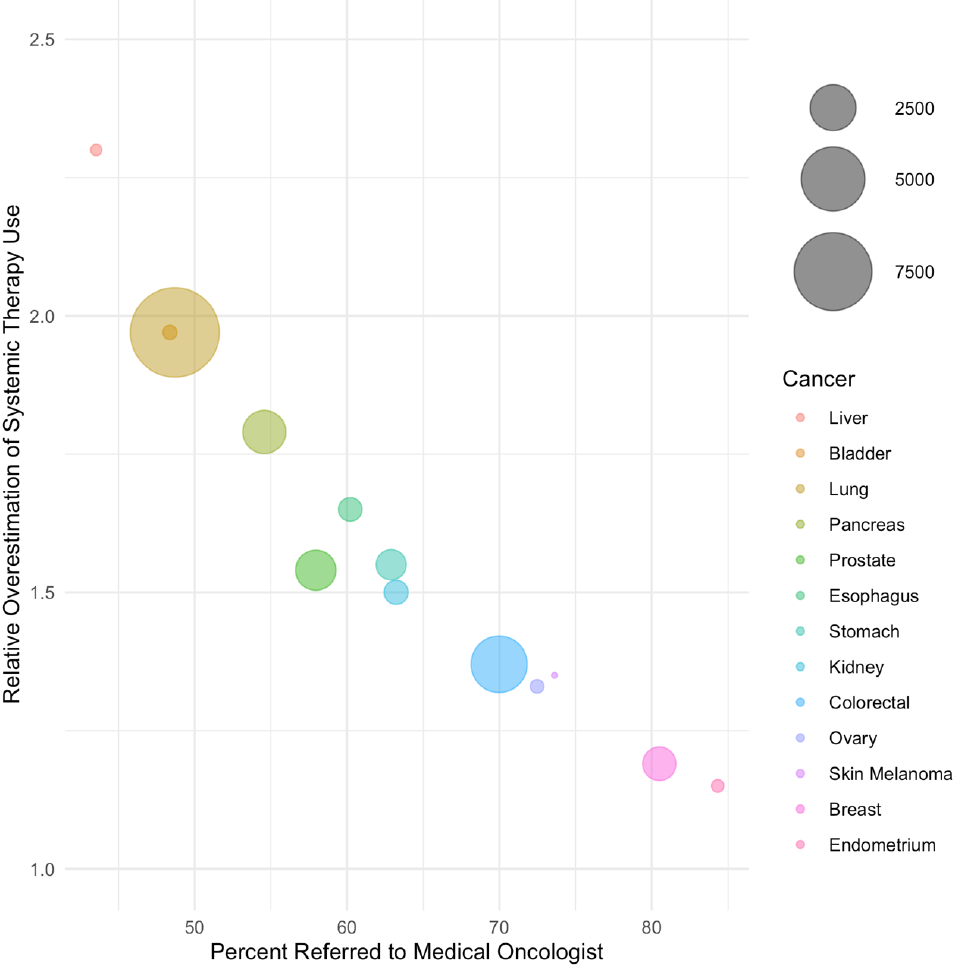
Figure 1. The relative overestimation of systemic treatment uptake in samples of referred patients compared to population-based samples by cancer site. Cancer sites are listed in order of ascending referral rate and bubble sizes are proportional to the number of patients in each cancer site.